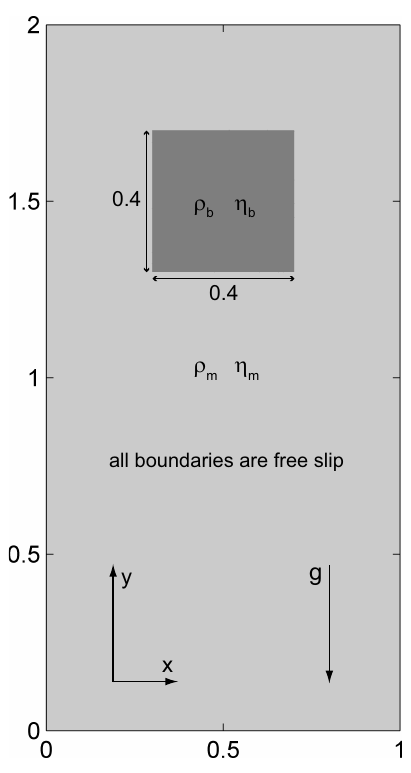
Figure 12. Sinking block model